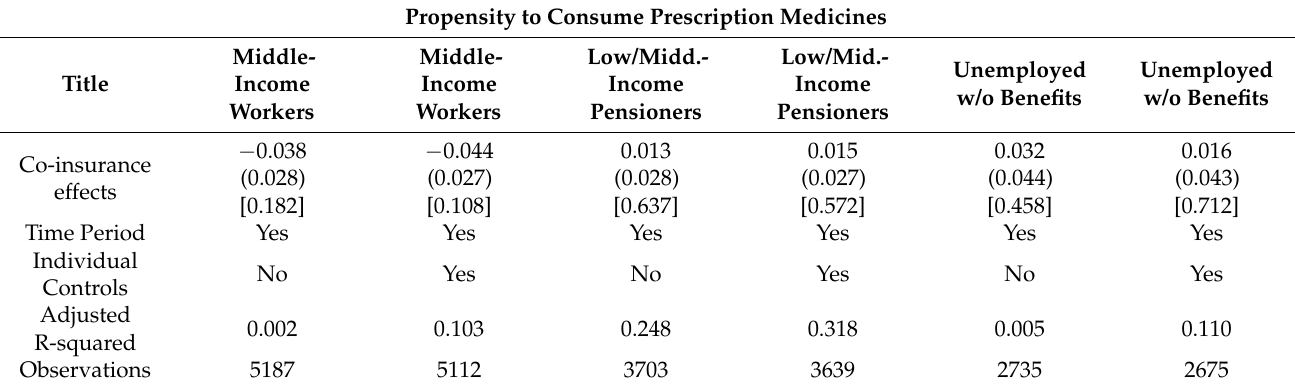
Table 5. Impact of the intervention on the propensity to consume prescription medicines.